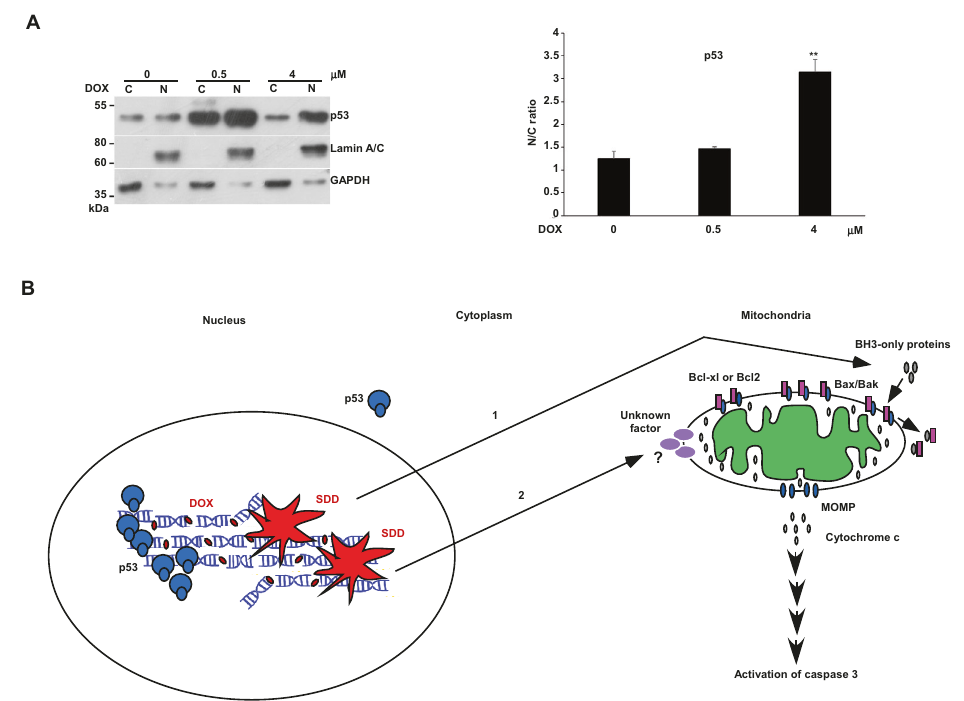
Fig. 7 p53 localization and the diagram of the dual control model. U2OS cells were incubated with various concentrations of DOX in 10-cm plates and harvested for nuclei and cytosol fractionation. The nuclei and cytosol fraction were analyzed by western blotting. The immunoblot image of p53 was shown. Lamin A/C and GAPDH were served as the speci fi c markers of nuclei and cytosol, respectively. The ratio of p53 in nuclei to p53 in the cytosol was quantitated as shown (** P < 0.01). N: nucleus. C: cytoplasm. Immune blots were cropped from different parts of the same gels and visualized by ECL with various exposure conditions dependent on the activity of antibodies. Representative blots from triplicate experiments were shown. A p53 localization. B SDD effect on apoptosis is mediated through a dual control